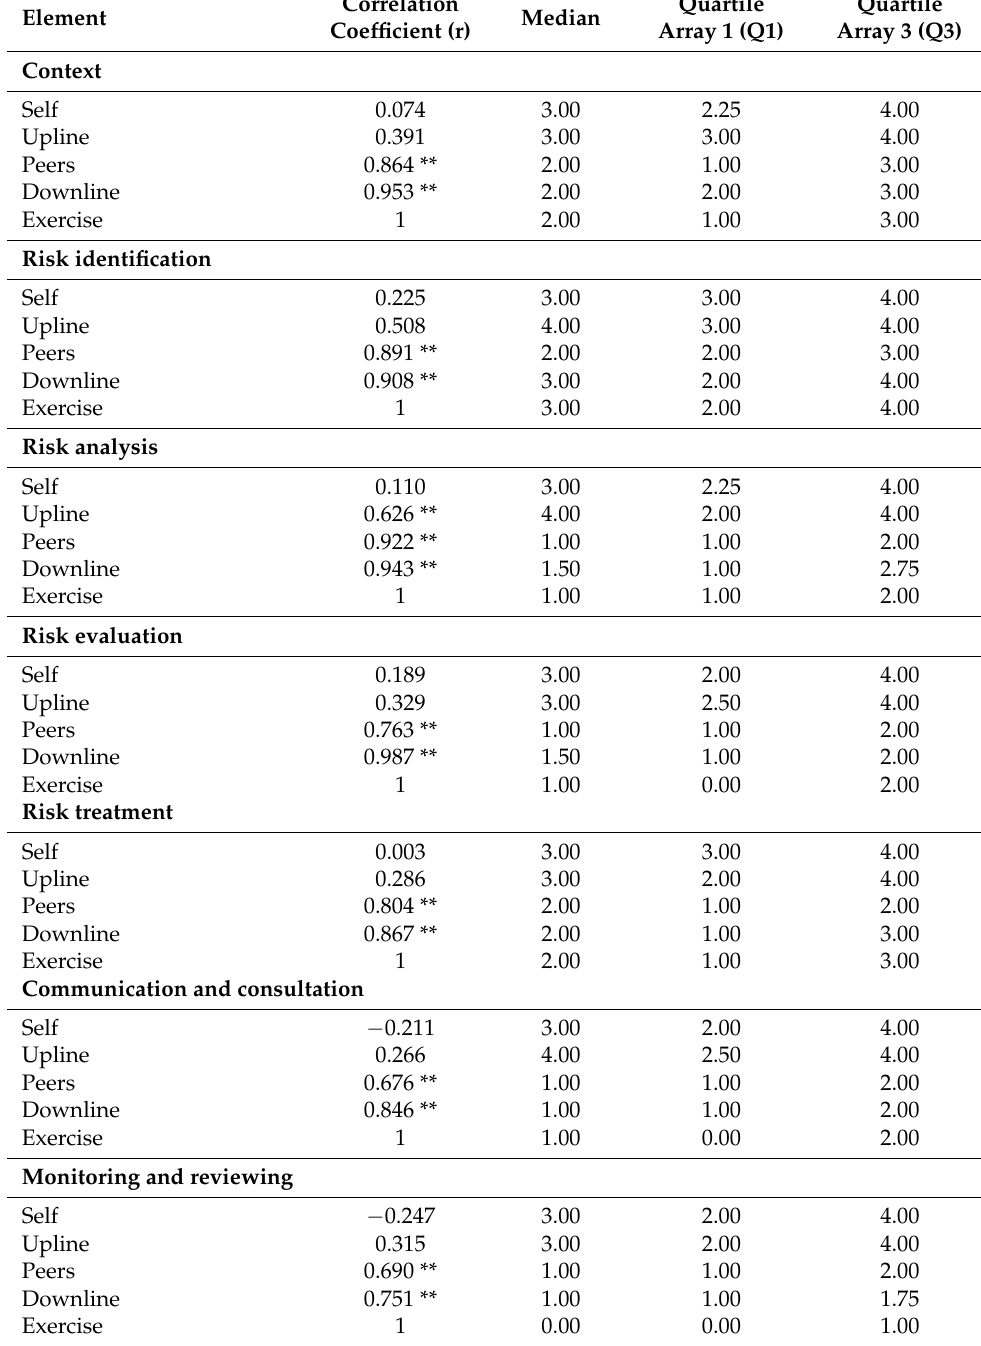
Table 3. Correlation coefficient, medians and interquartiles RISKometric (self, upline, peer and downline) and risk scenario exercise competence ratings for the seven elements of the risk manage- ment process.